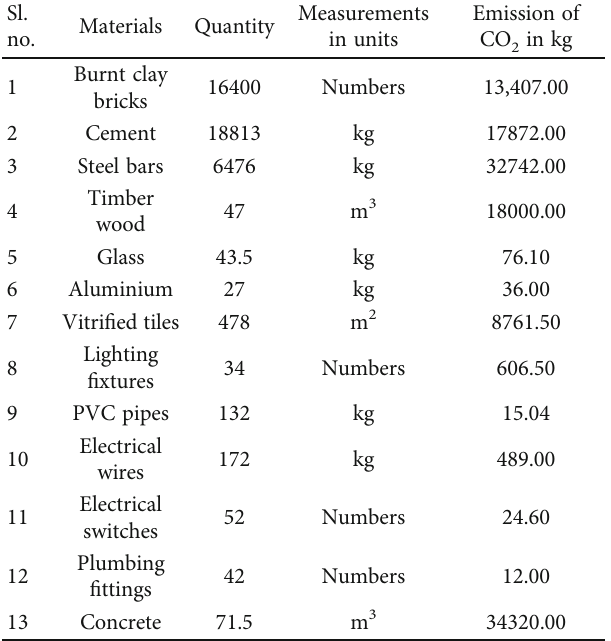
Table 3: Materials and carbon emission in the construction stage. Sl.